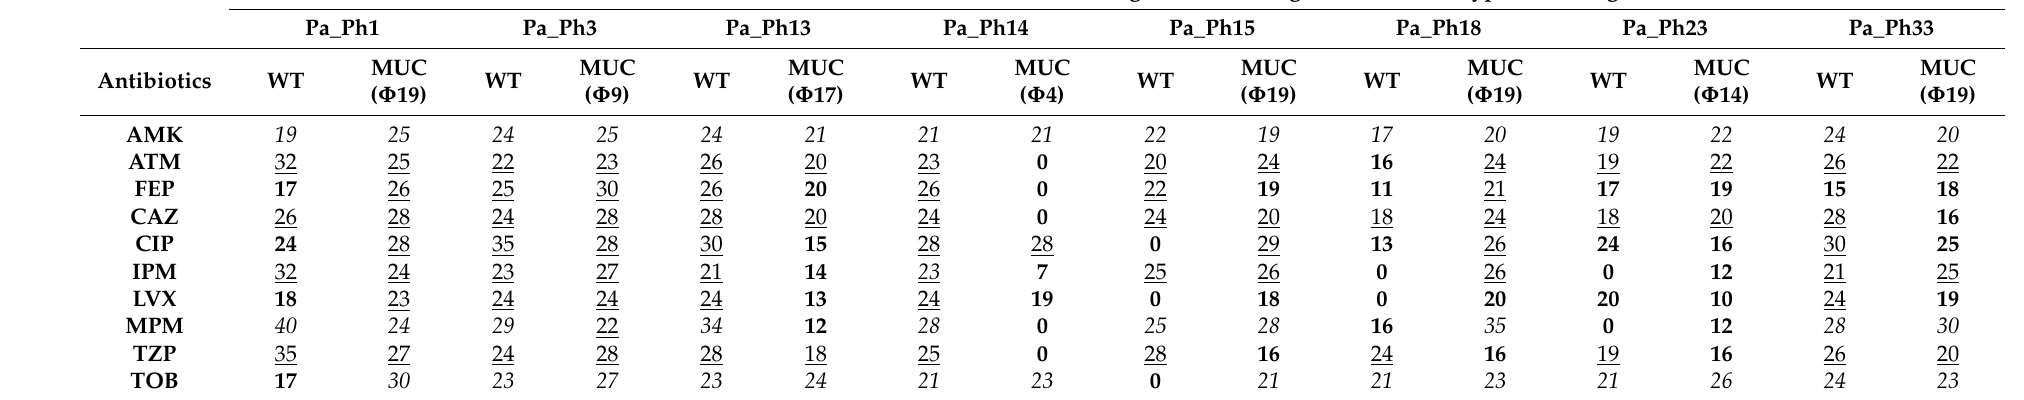
Table 3. In vitro antibiotic activity comparing ancestral cystic fibrosis (CF) Pseudomonas aeruginosa (Pa) isolates (wild type, WT), and their switched mucoid (MUC) Pa phenotypes induced by phage